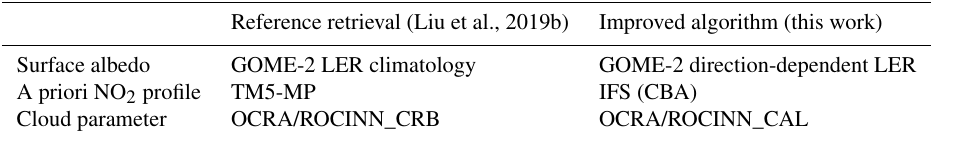
Table 1. Ancillary parameters used to derive GOME-2 tropospheric NO 2 columns. See Table 2 for details regarding the chemistry transport models used to obtain the a priori NO 2 profiles.